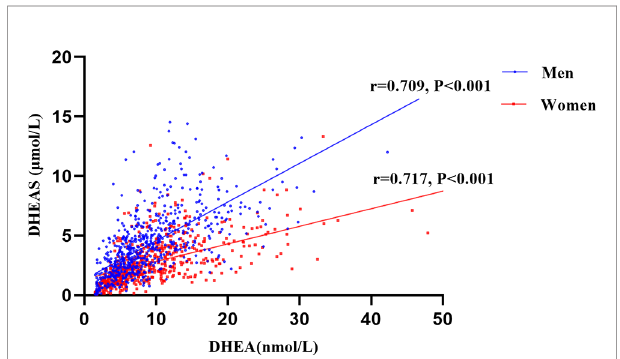
FIGURE 2 | The correlations between serum dehydroepiandrosterone (DHEA) and dehydroepiandrosterone sulfate (DHEAS) among men and women in this study. Figure 2 indicates that serum DHEA and DHEAS were highly collinear in this study. (r = 0.709; P < 0.001 among men; r = 0.717; P < 0.001 among women).